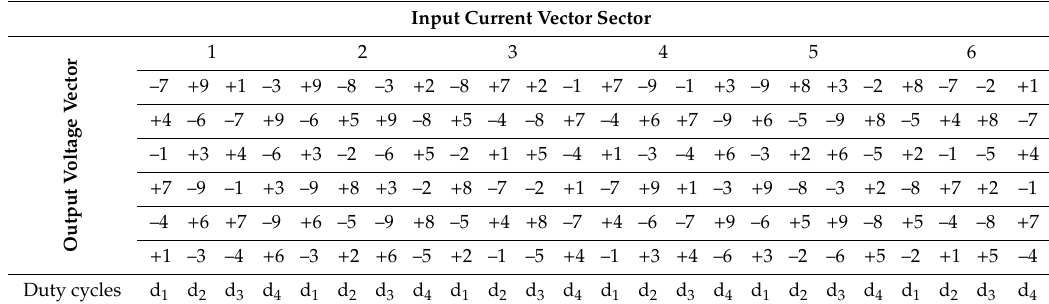
Table 2. Selected active-vector states for each combination of output voltage and input current sectors in the traditional space vector modulation